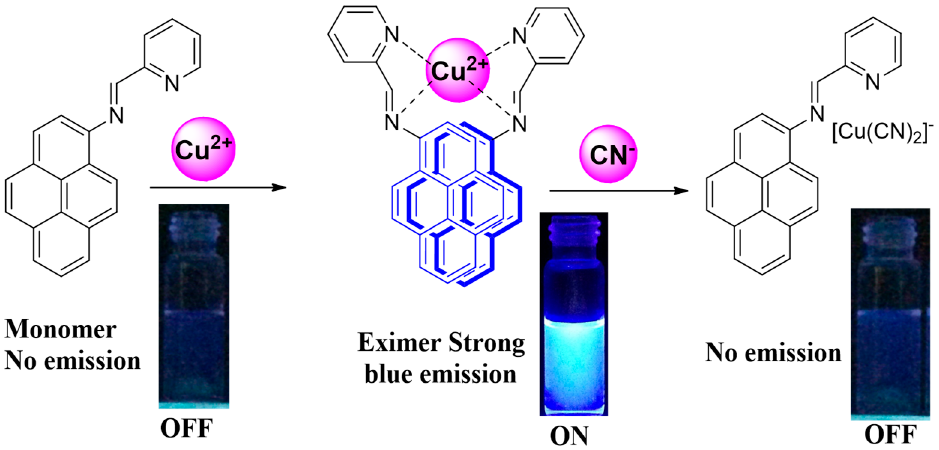
Figure 1. Schematic of L-based emission changes, excimer complex formation, and reversibility during the sequential detection of Cu 2+ and CN ˗ .